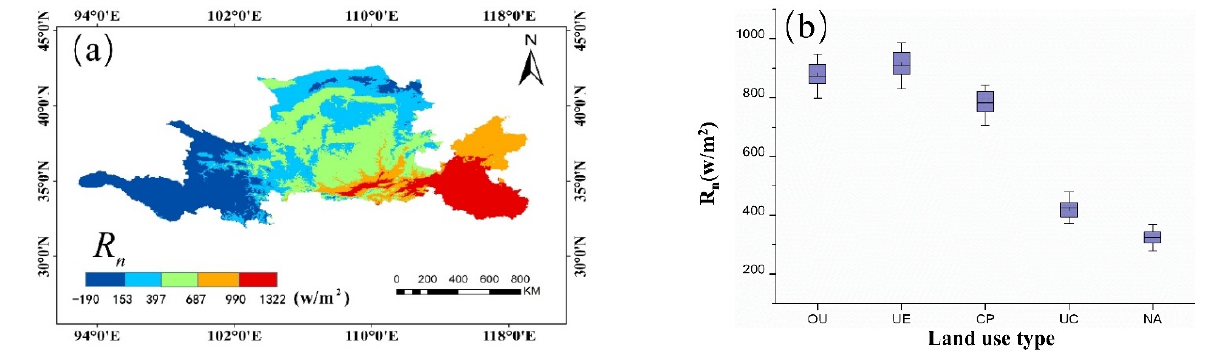
types from 2000 to 2015.